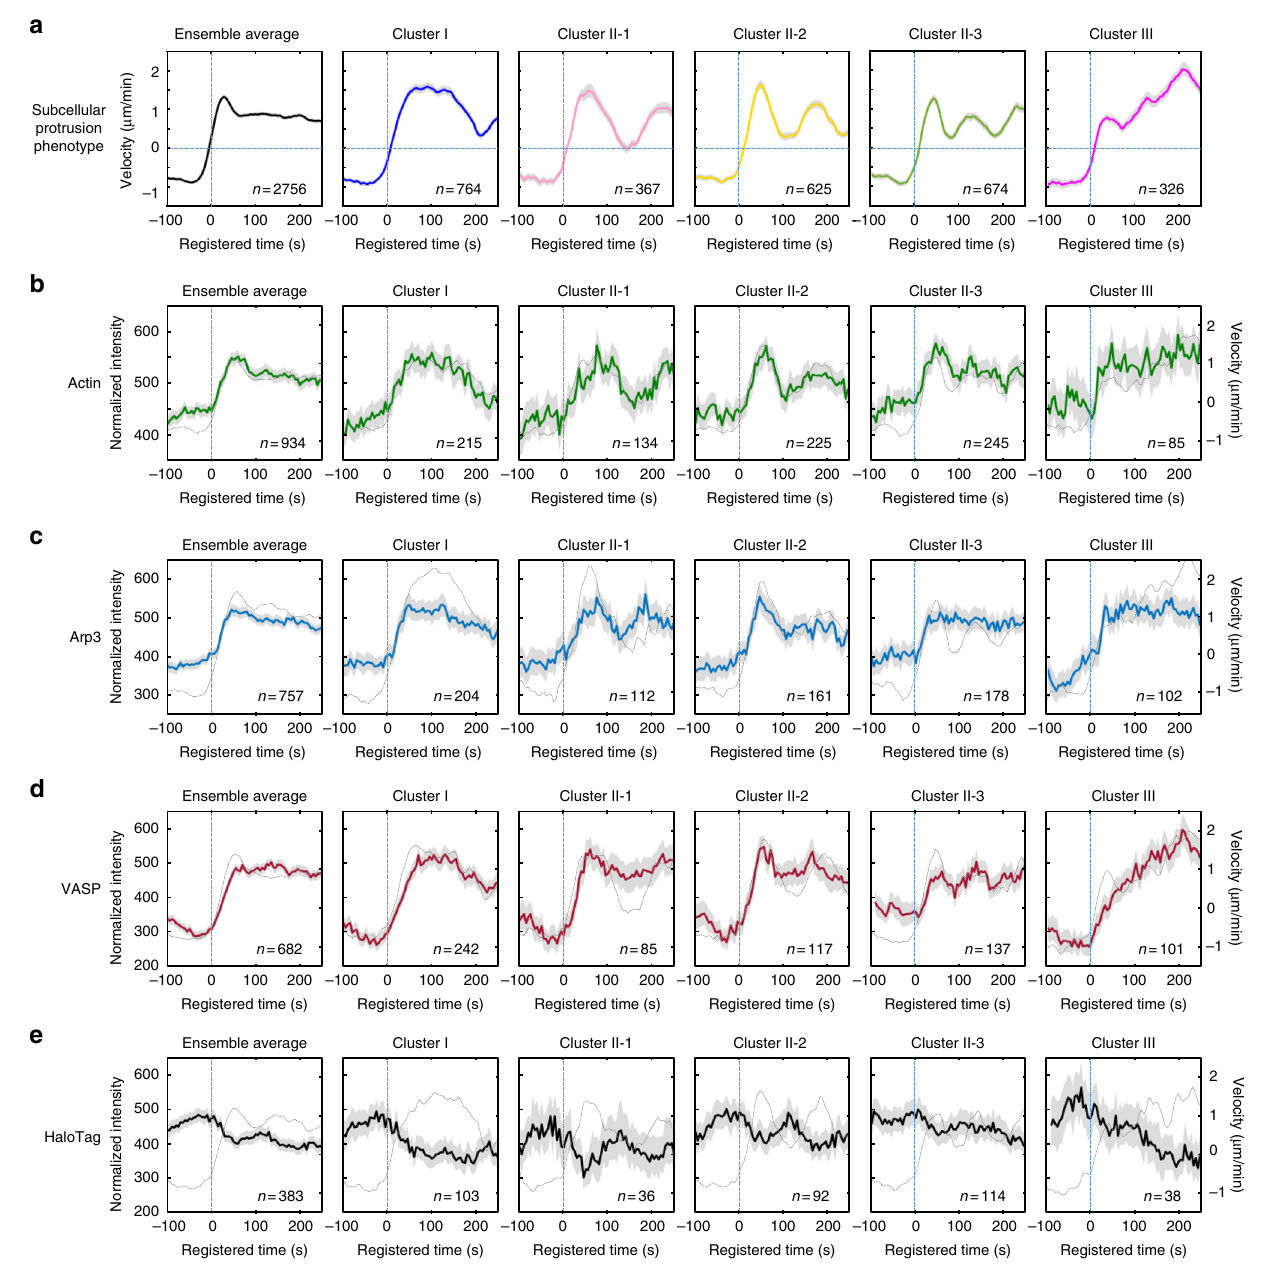
Fig. 3 Distinctive actin regulator dynamics associated with subcellular protrusion phenotypes. a Ensemble averaged velocity time series of entire samples and averaged velocity time series sampled in each cluster. All time series are registered with respect to protrusion onset ( t = 0). b – e Ensemble averaged normalized fl uorescence intensity time series of entire samples and normalized fl uorescence intensity time series in each cluster. All time series are registered with respect to protrusion onset ( t = 0). Solid lines indicate population averages. Shaded error bands indicate 95% con fi dence intervals of the mean computed by bootstrap sampling. The dotted lines in b - e indicate protrusion velocity time series associated with the indicated fl uorescent proteins. n indicates the number of time series sampled in each cluster. The numbers of cells used for the analyses are 36 ( a ), 10 ( b ), 11 ( c ), 9 ( d ) and 6 ( e ) respectively. The number of time series sampled and the number of cells imaged for each cluster is summarized in Supplementary Table